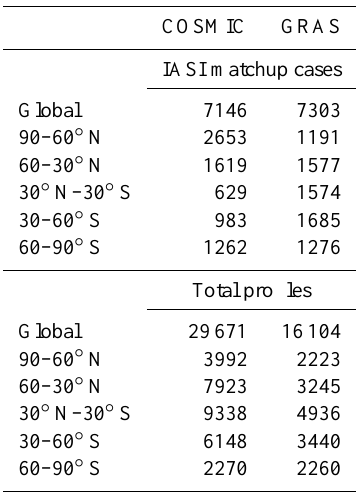
Table 3. Number of COSMIC and GRAS profiles and matchup cases with IASI for May 2012 selected latitude zones.